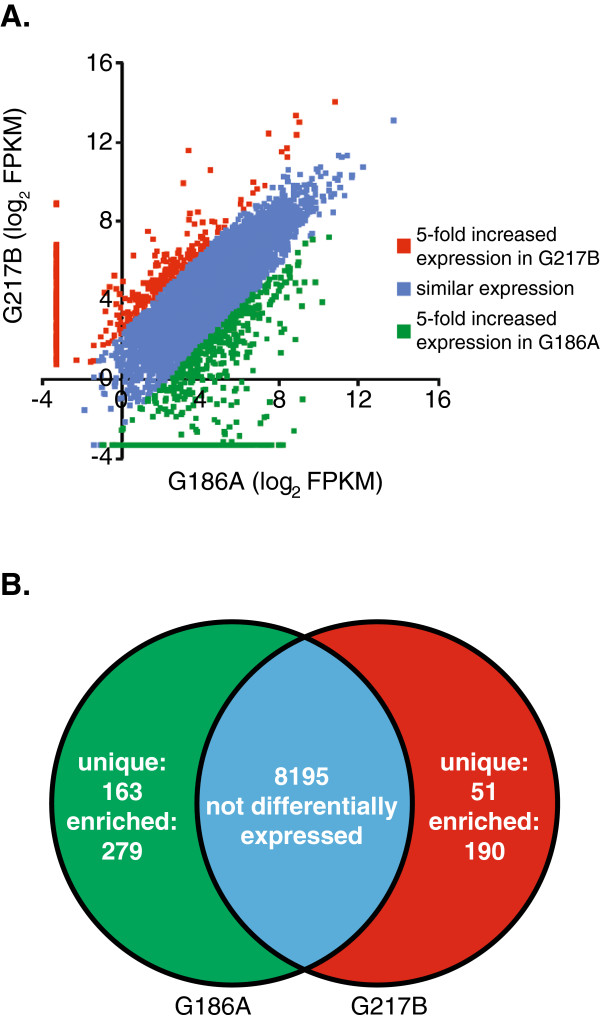
Yeast-phase expressed genes with lineage-specific gene expression differences. Expression levels of individual genes in G186A and G217B were compared using FPKM values for yeast-phase cells. (A) Data points represent the log2 transformation of the expression (FPKM) of individual genes in G186A yeasts (x-axis) and G271B yeasts (y-axis). Data point color indicates genes with similar expression levels in G186A compared to G217B (blue; less than 5-fold change), genes with significantly increased expression in G186A yeast (green; at least 5-fold), or genes with significantly increased expression in G217B yeast (red; at least 5-fold). Data points clustering at log2(FPKM) = -3.32 represent genes whose expression was FPKM < 0.1, which were then set to (FPKM = 0.1) as the lowest reasonable limit of detection. (B) Venn Diagram of lineage-specific gene expression: genes not differentially expressed (blue overlap) or genes with increased expression (at least 5-fold) in G186A yeast (green) or in G217B yeast (red). Genes with strain-specific expression were further divided into those that were structurally unique to the G186A or G217B genome (unique) or orthologous genes that were differentially expressed by G186A and G217B yeasts (enriched).